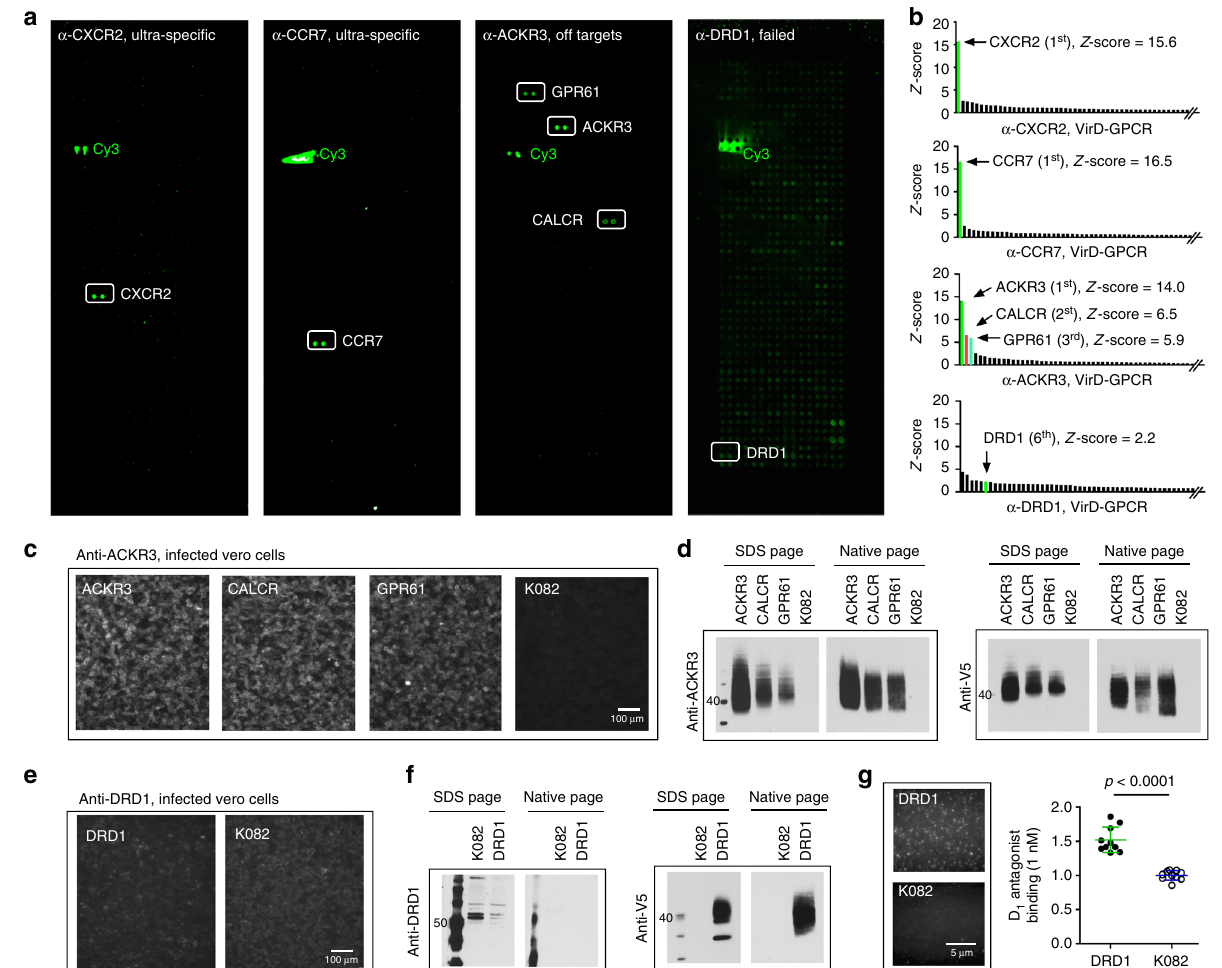
Fig. 2 Speci fi city tests of commercial mAbs on VirD-GPCR arrays. a Examples of binding signals obtained with commercial mAbs. Anti-CXCR2 and -CCR7 are shown as ultra-speci fi c; anti-ACKR3 can cross-react with CALCR and GPR61; anti-DRD1 completely failed to recognize its target while showing nonspeci fi c binding activities to other GPCRs. b Histograms of Z -scores obtained with three mAbs. Z -scores of the two off- targets identi fi ed by anti- ACKR3 are also shown. c Immuno fl uorescence analysis (IFA) validation of anti-ACKR3 to its off-targets in infected Vero cells. K082-infected cells are shown as a negative control. d Immunoblot analysis also con fi rmed that anti-ACKR3 can recognize its two off-targets in the cell lysates of infected Vero cells under both denatures and native conditions. e , f Anti-DRD1 failed to recognize DRD1 in VirD-DRD1-infected cells using IFA ( e ) or immunoblot (IB) analyses ( f ). g Single-molecule imaging using TIRF microscopy to determine interactions between VirD-DRD1 and its canonical ligand D 1 antagonist. K082 virions were used as a negative control. Quantitative analysis of TIRF imaging demonstrated that VirD-DRD1 showed signi fi cantly higher binding signals to D 1 antagonist than K082. Data were analyzed with two-tailed Student ’ s t -test, n =